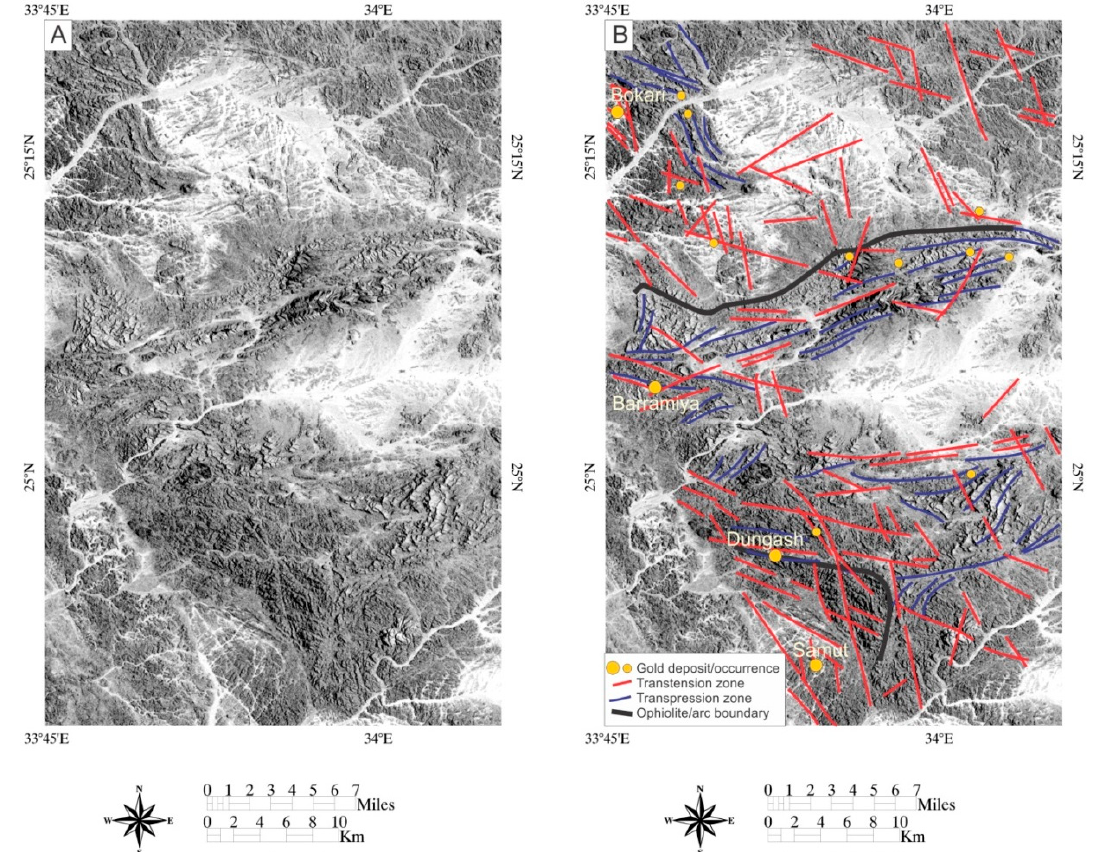
Figure 2. Processed Sentinel-1 data of the Barramiya–Mueilha area showing: ( A ) Feature-oriented Principal Components Selection (FPCS2) highlighting the variable styles of deformation in the study area. ( B ) Same as in A with interpreted structural elements and locations of gold deposits/occurrences. For more details please refer to the next sections.